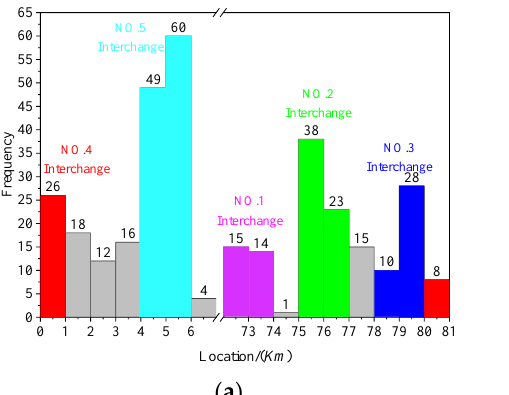
Figure 4. Order of importance of influencing factors.